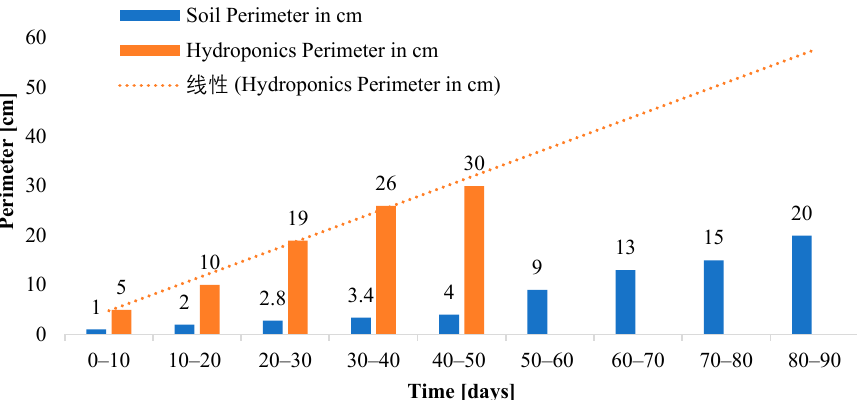
Figure 16. Comparison of romaine lettuce leaf perimeter grown in soil and the NFT hydroponic setup.